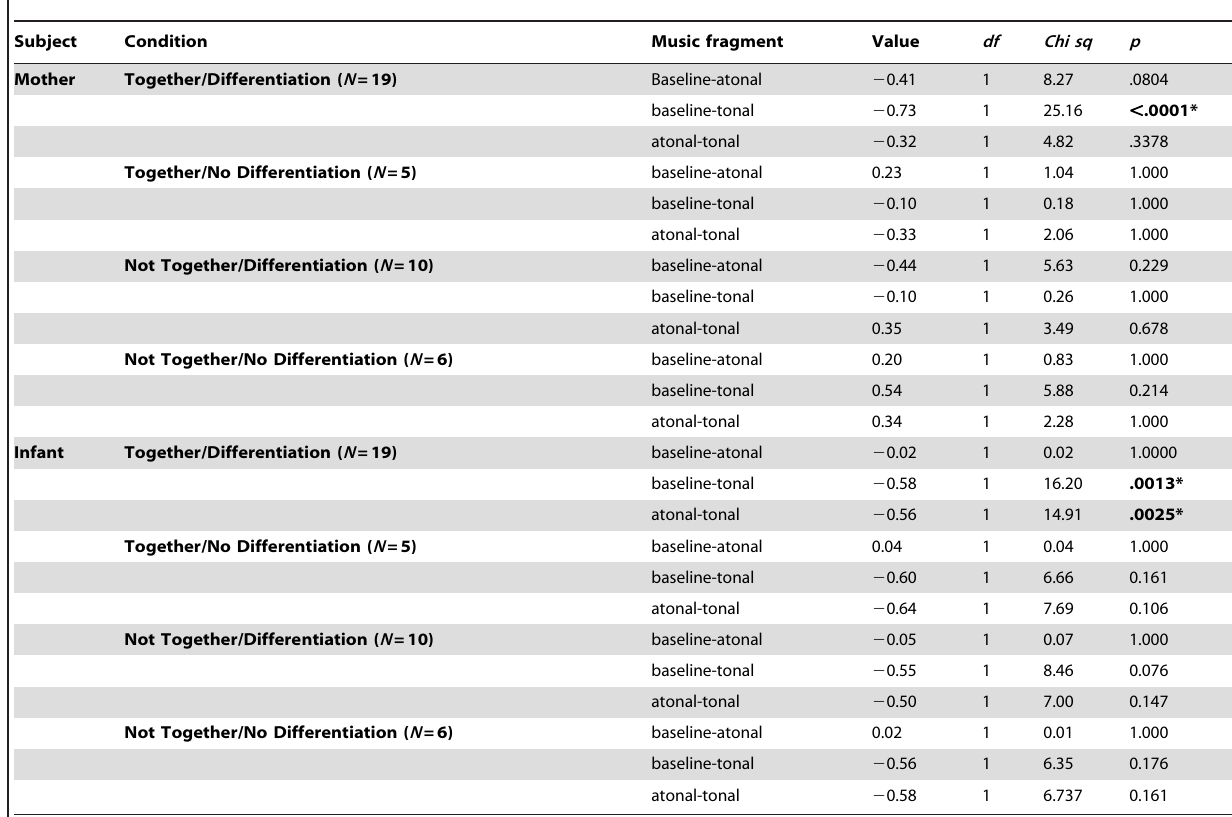
Table 5. Overview of the effect on RSA of listening to the tonal and atonal fragments for infants and